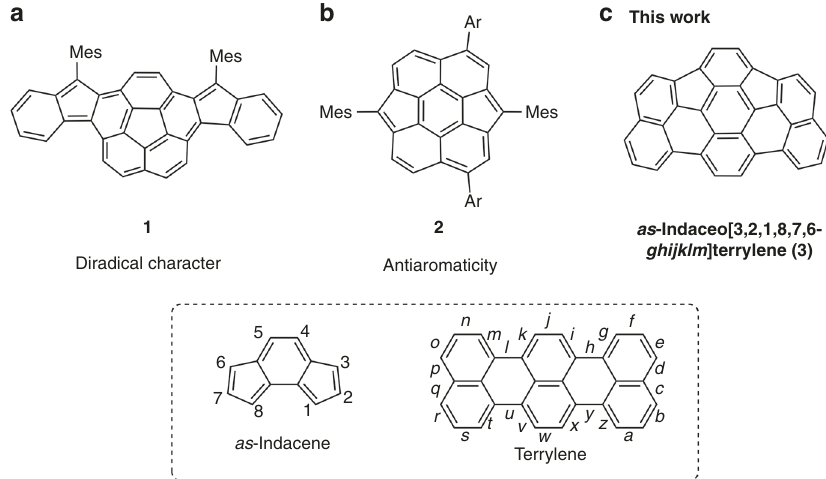
Fig. 1 NIR-absorbing bowl-shaped (anti)aromatic hydrocarbons 1 – 3. a Indene-fused corannulene derivative 1 . b Dicyclopenta[4,3,2,1- ghi :4 ′ ,3 ′ ,2 ′ ,1 ′ - pqr ] perylene ( 2 ). c as -Indaceno[3,2,1,8,7,6- ghijklm ]terrylene ( 3